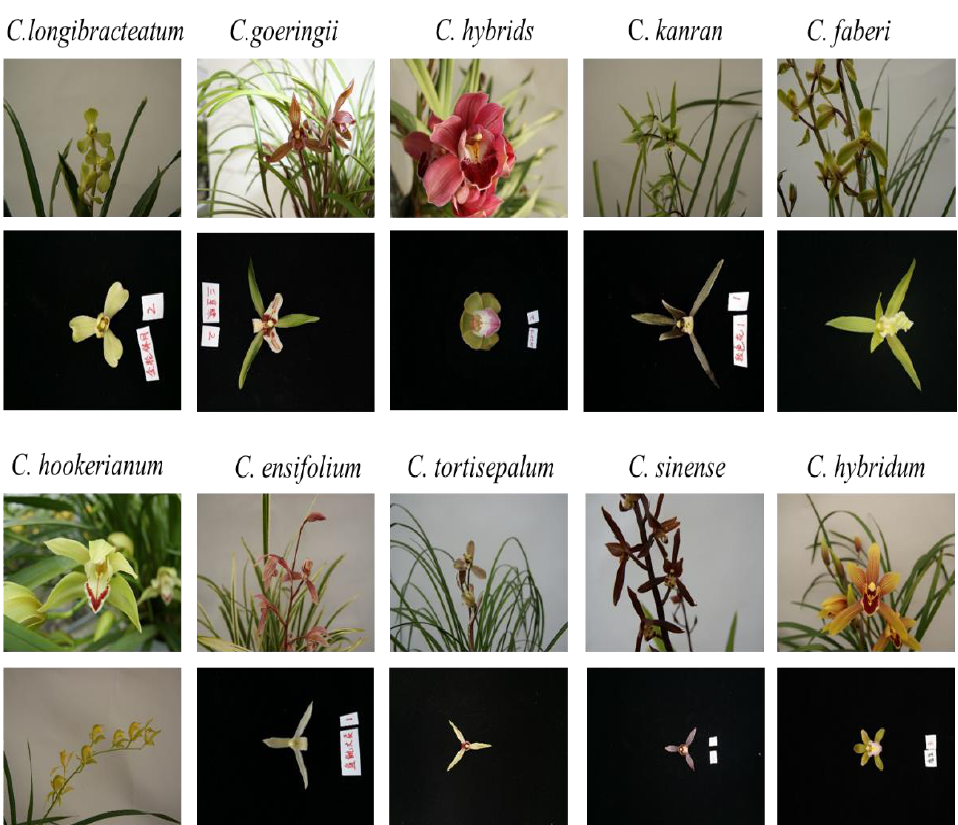
Figure 1. Examples of pictures of 10 Cymbidium species.